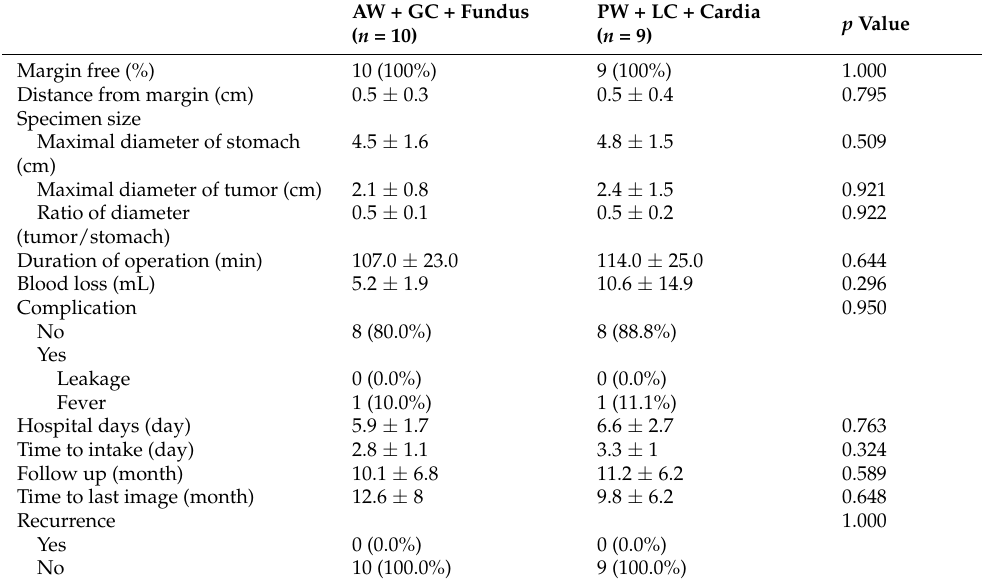
Table 3. Perioperative outcome.